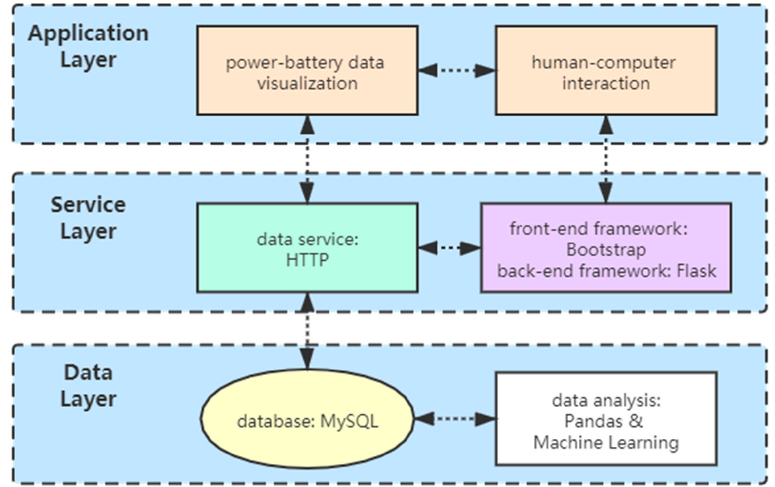
Figure 1. The architecture diagram of this platform.